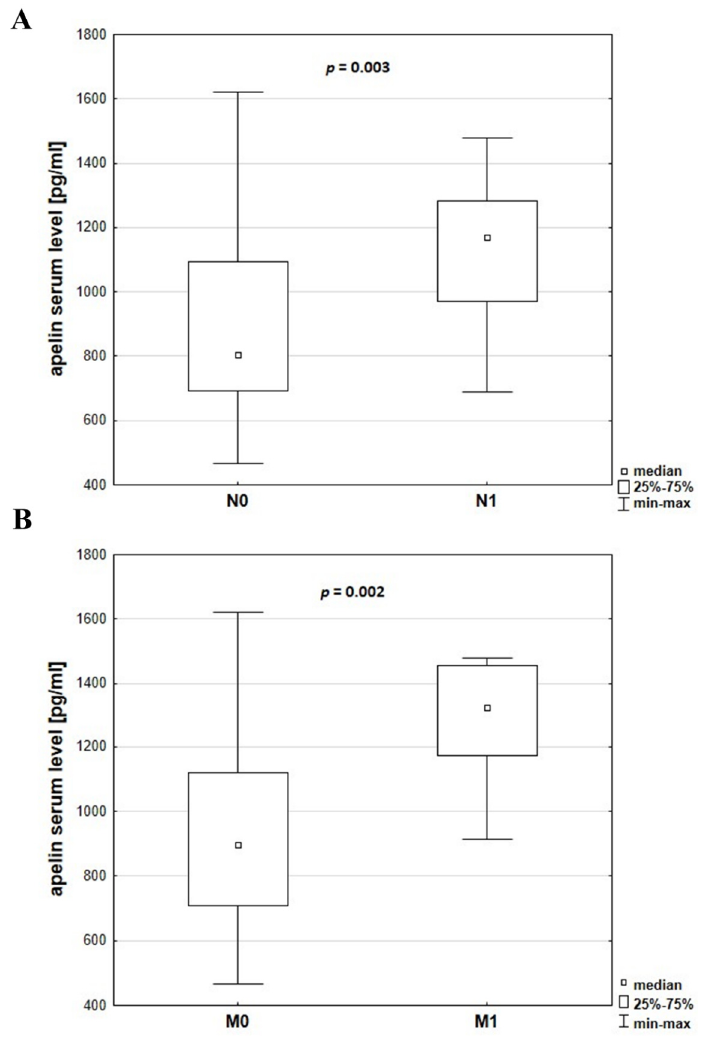
Figure 3. Apelin serum levels in CRC patients without (N0) or with (N1) lymph node metastasis ( A ) or without (M0) or with (M1) distant metastasis ( B ). The data were analysed using the Mann–Whitney U test.